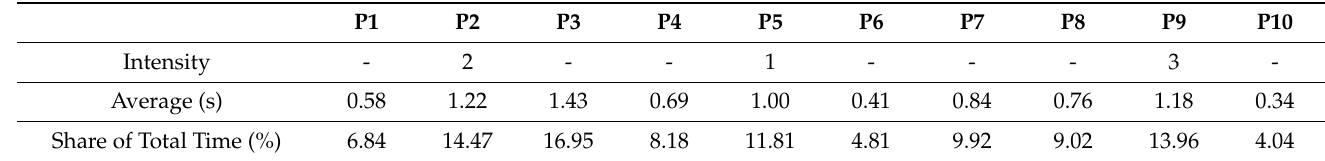
Table 5. Fixation times in the product category with borders. Source: own